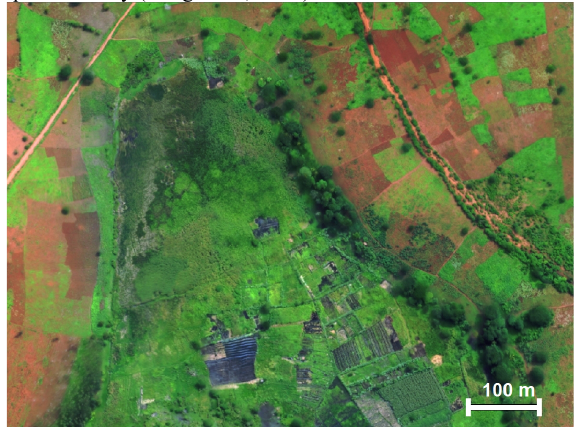
Figure 4. Detail of the ortho-photo from the wet season 19.05.2012